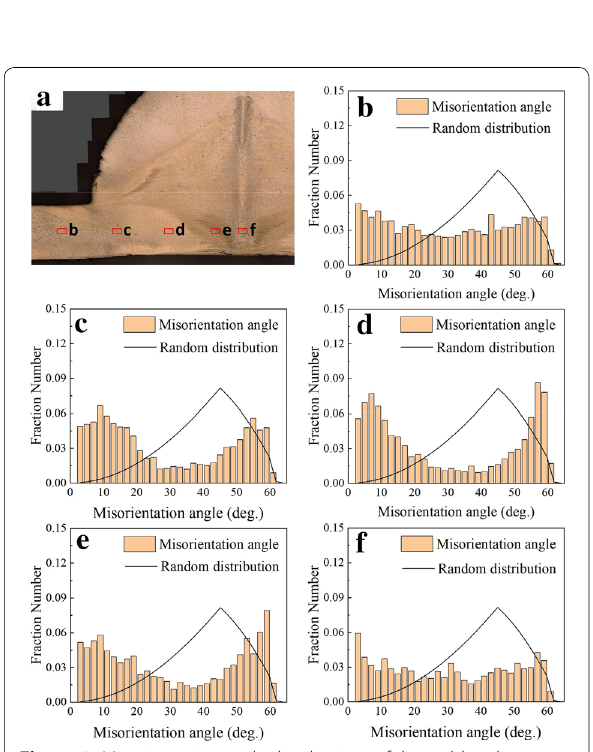
Figure 9 Misorientation angle distributions of the weld and the vortex material flow zone (300 r/min): a schematic of the measured location; b ‒ f Misorientation angle distribution histograms corresponding to the locations b ‒ f in